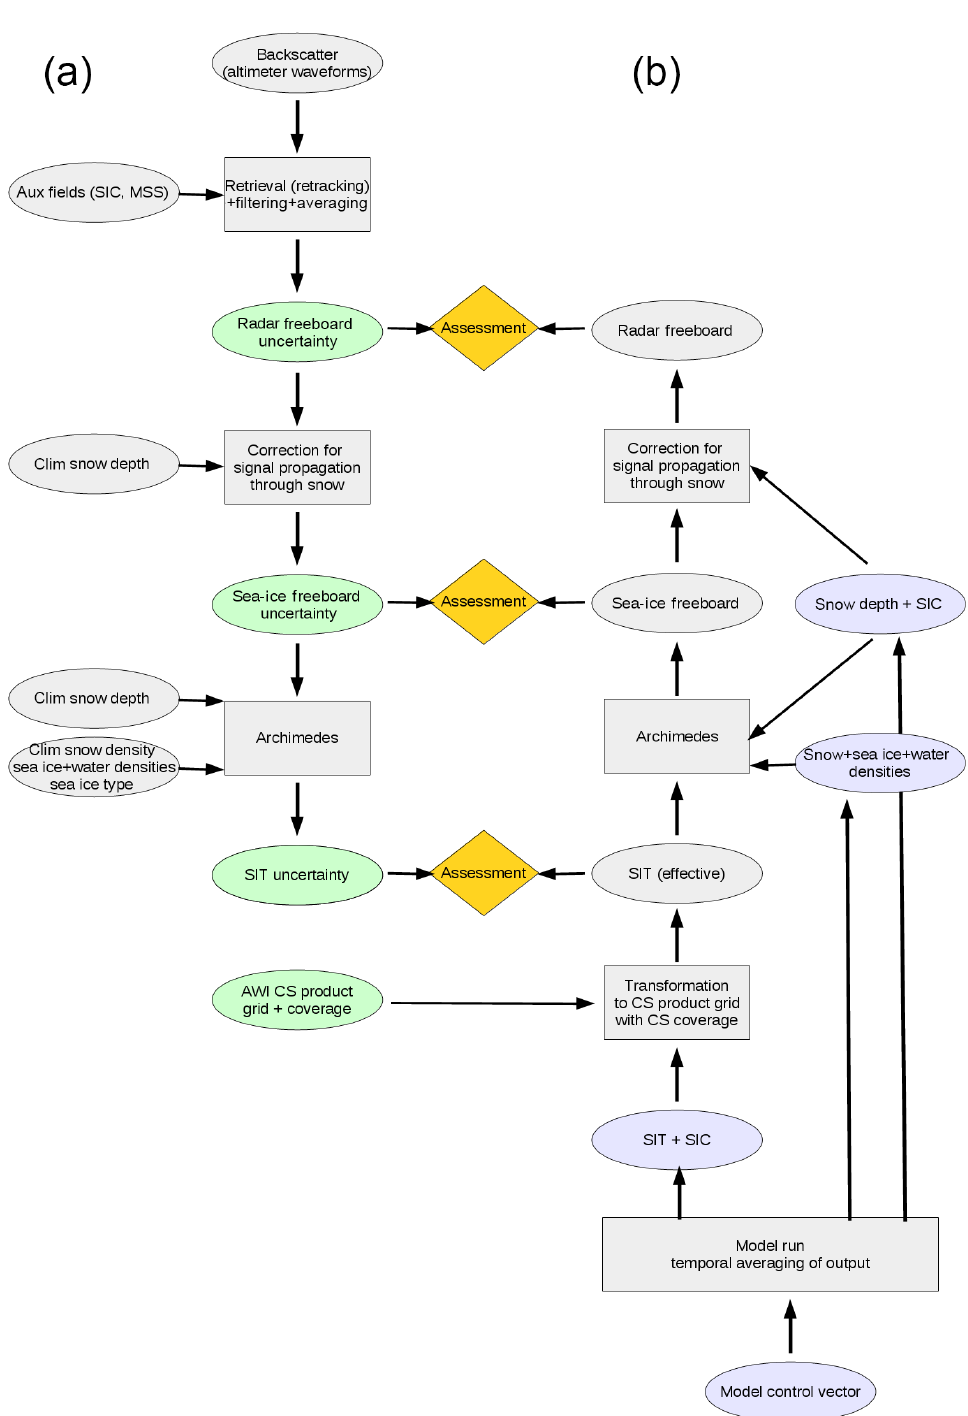
Figure 12. Overview of the processing chain for CryoSat-2 (CS) product retrievals ( a ) and the chain for modelling product equivalents from the control vector ( M( x ) ; b ). Oval boxes denote data and rectangular boxes processing steps. Green indicates remote-sensing products and violet indicates model variables. Yellow diamonds mark the assessment of the EO products with the QND algorithm. MSS is mean sea surface